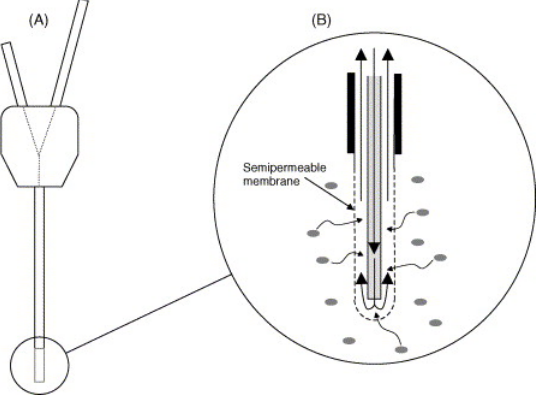
Figure 7. Microdialysis probe. A microdialysis probe is formed by a semipermeable membrane and perfused at a constant flow. Molecules will be able to diffuse across the membrane according to their gradient